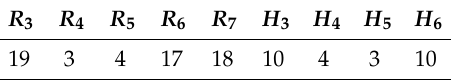
Table 2. Dimensions of the cone loaded cylinder cavity (mm).